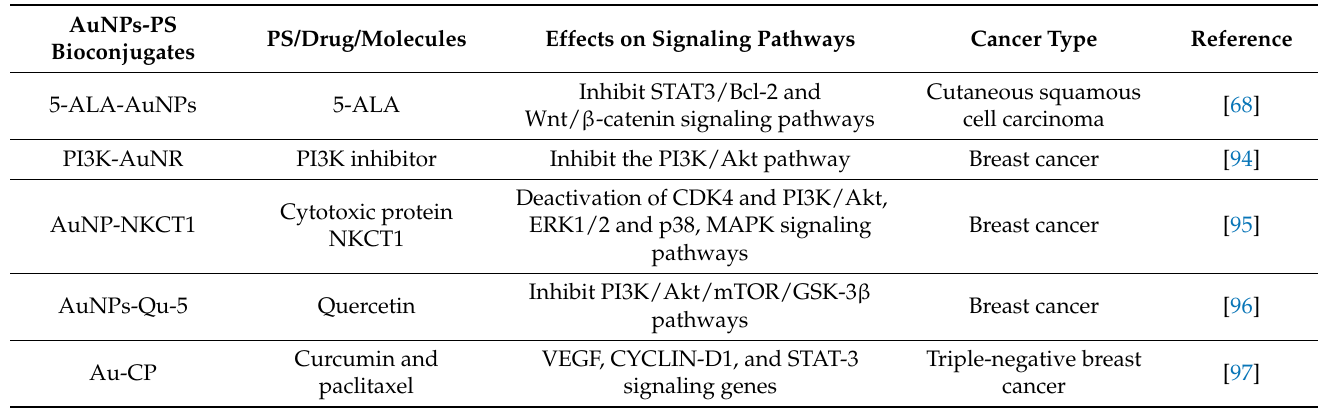
Table 3. Gold nanoparticle bioconjugates actively targeting tumor signaling pathways of cancer.